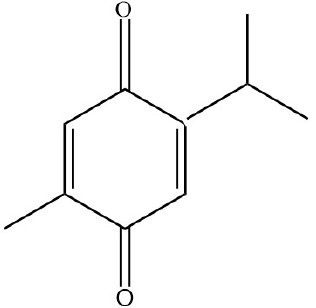
Figure 1. Thymoquinone chemical